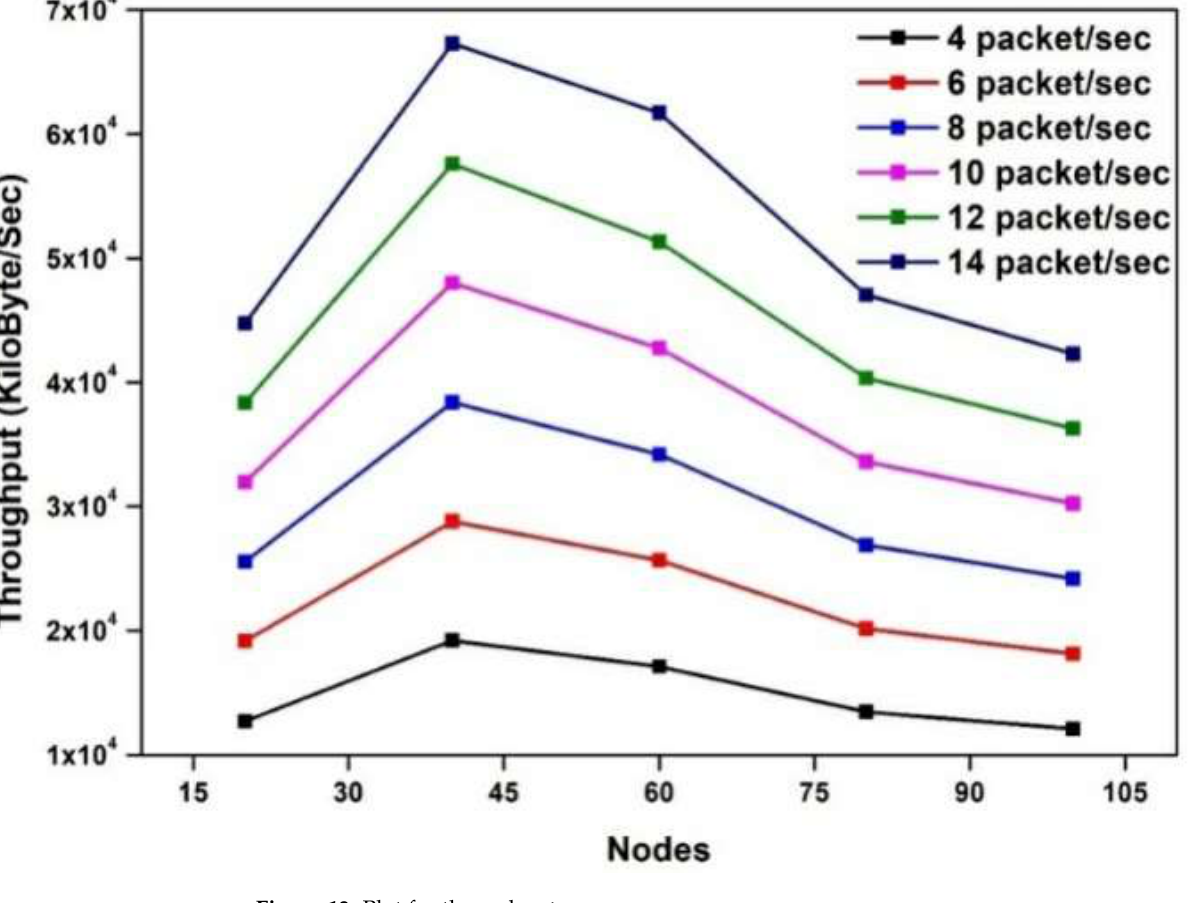
Figure 13. Plot for